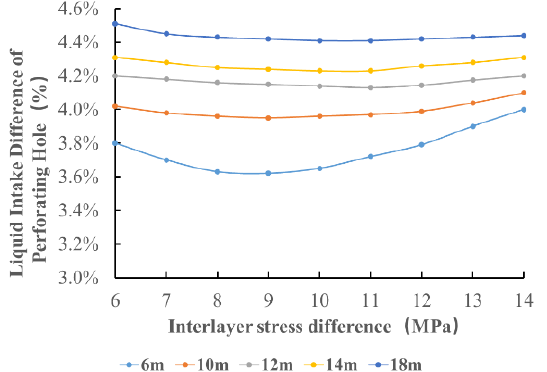
Figure 5. Effect of different reservoir thickness on stress difference between lower layers.